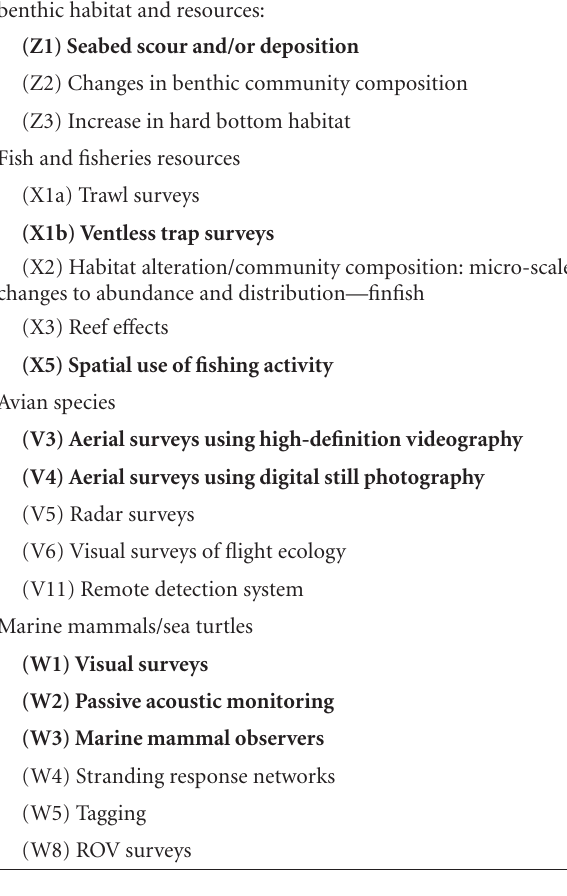
Table 14: Monitoring protocols relevant to addressing the potential impacts identified from the Impact decision tree and component decision trees for the case study of a scale 2 ( ∼ 200 devices) jacketed wind turbine farm involving pile driving. Protocols in bold face represent those that uniquely address the Impact scenario and local concerns and should thus be prioritized for